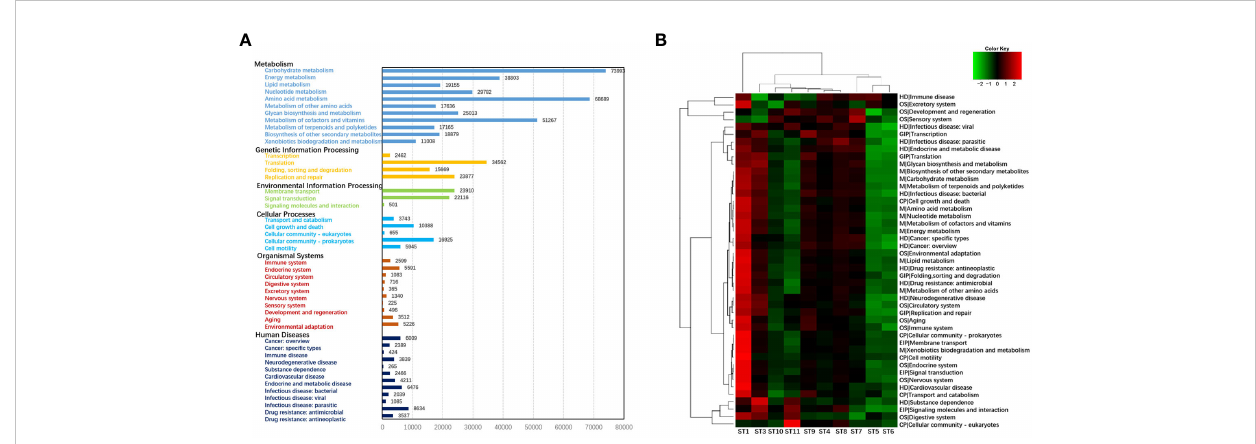
FIGURE 5 KEGG annotation of summer metagenomic data (A) and relative abundance analysis of subpathways among related samples (B) . (A) The number of unigenes of the level 1 (KEGG metabolic pathway fi rst level) and level 2 (KEGG metabolic pathway second level) in KEGG annotation results. (B) Heat map of the abundance of functional genes in different samples (red indicates the higher relative abundance, while green indicates the lower relative